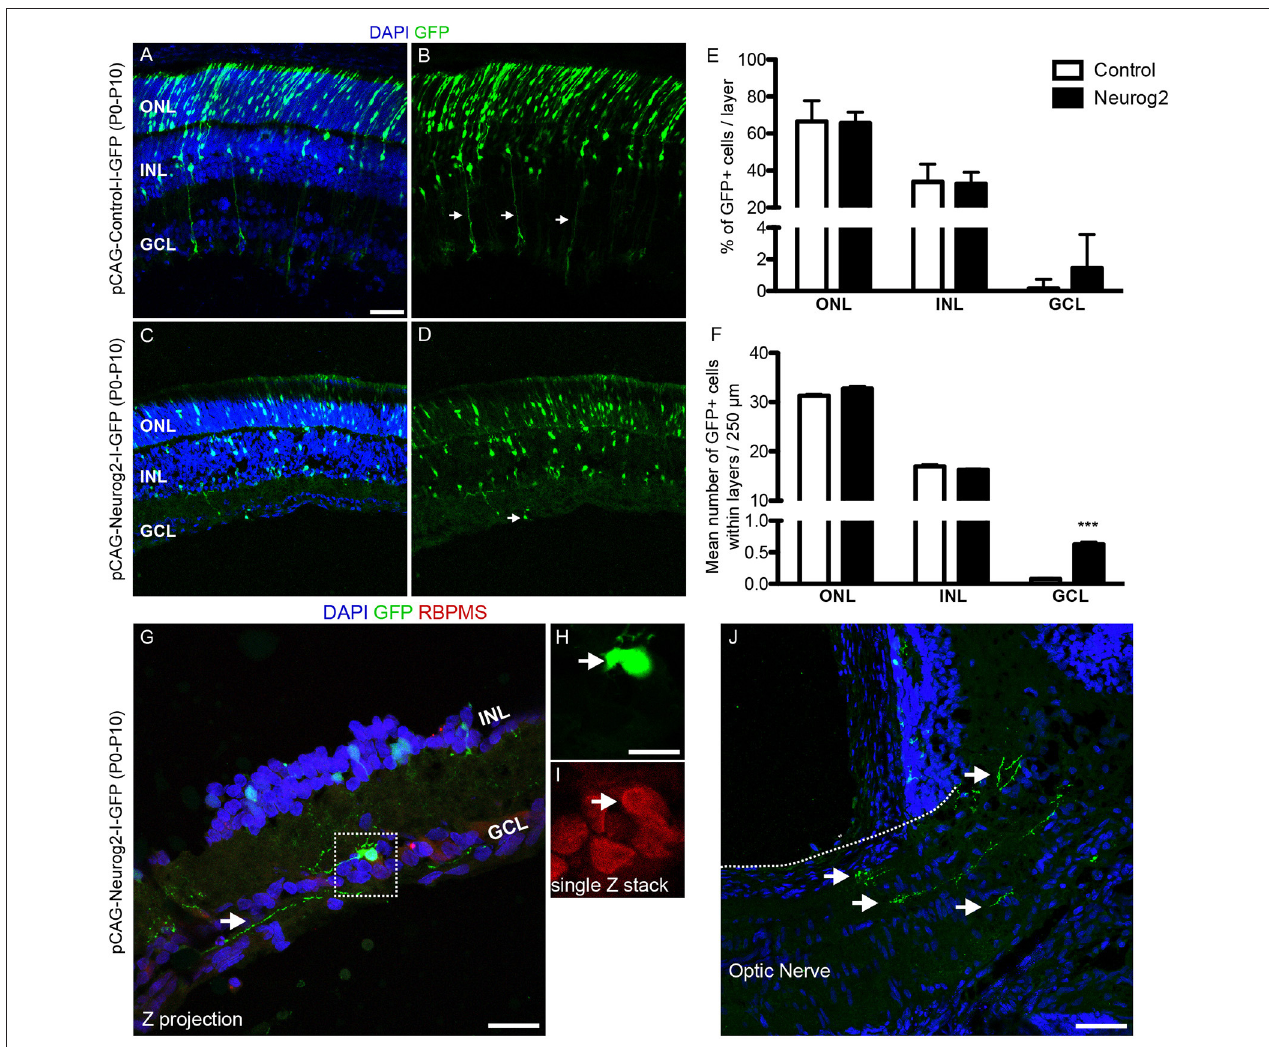
FIGURE 7 | Forced-expression of NEUROG2 resumes the generation of RGCs in the developing retina in vivo . (A–D) Representative images of P10 rat retinas after electroporation with control-I-GFP (A,B) and Neurog2-I-GFP (C,D) plasmids at P0. Note the presence of GFP + radial fibers typical of MGCs (arrows in B ) and the complete absence of GFP + cells in the GCL in controls. Observe also the decrease of GFP + cells in the ONL and the presence of GFP + cells in the GCL of Neurog2-electroporated retina (arrow in D ). (E) Frequencies of GFP + cells in the ONL, INL e GCL of the retina of control- and Neurog2-electroporated animals. (F) Mean numbers of GFP + cells within the ONL, INL or GCL per 250 µ m longitudinal section (*** p < 0.001; Two-way ANOVA, Bonferroni post-hoc test). (G–I) Expression of RBPMS (red) in GFP + cells (green) within the GCL of Neurog2-electroporated retinas. White arrow points to the axon-like process of the GFP + cell observed within the GCL. Dashed box (G) is amplified in H and I to show the co-localization of GFP and RBPMS in a single confocal Z-stack. (J) Axon-like GFP + processes (arrows) reaching the optic nerve in a Neurog2-electroporated retina. Nuclei are stained with DAPI (blue). Scale bars: A-D and J : 50 µ m; G : 25 µ m; H-I : 12,5 µ